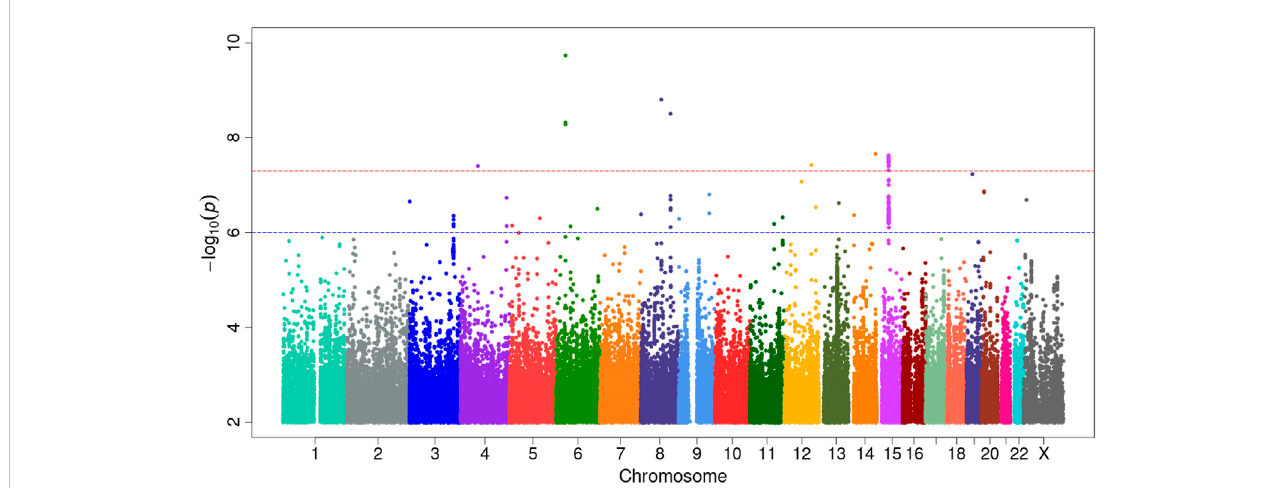
FIGURE 1 Genome-wide association study analysis for variants associated with pulmonary arterial hypertension. Manhattan plot of GWAS results with minor allele frequency > 0.5% for PAH. The red dotted line denotes genome wide signi fi cance at p = 5E-8. The signi fi cance is displayed on the y -axis as -log10 of the p -value, and the results lie according to their chromosomal location on the x -axis.